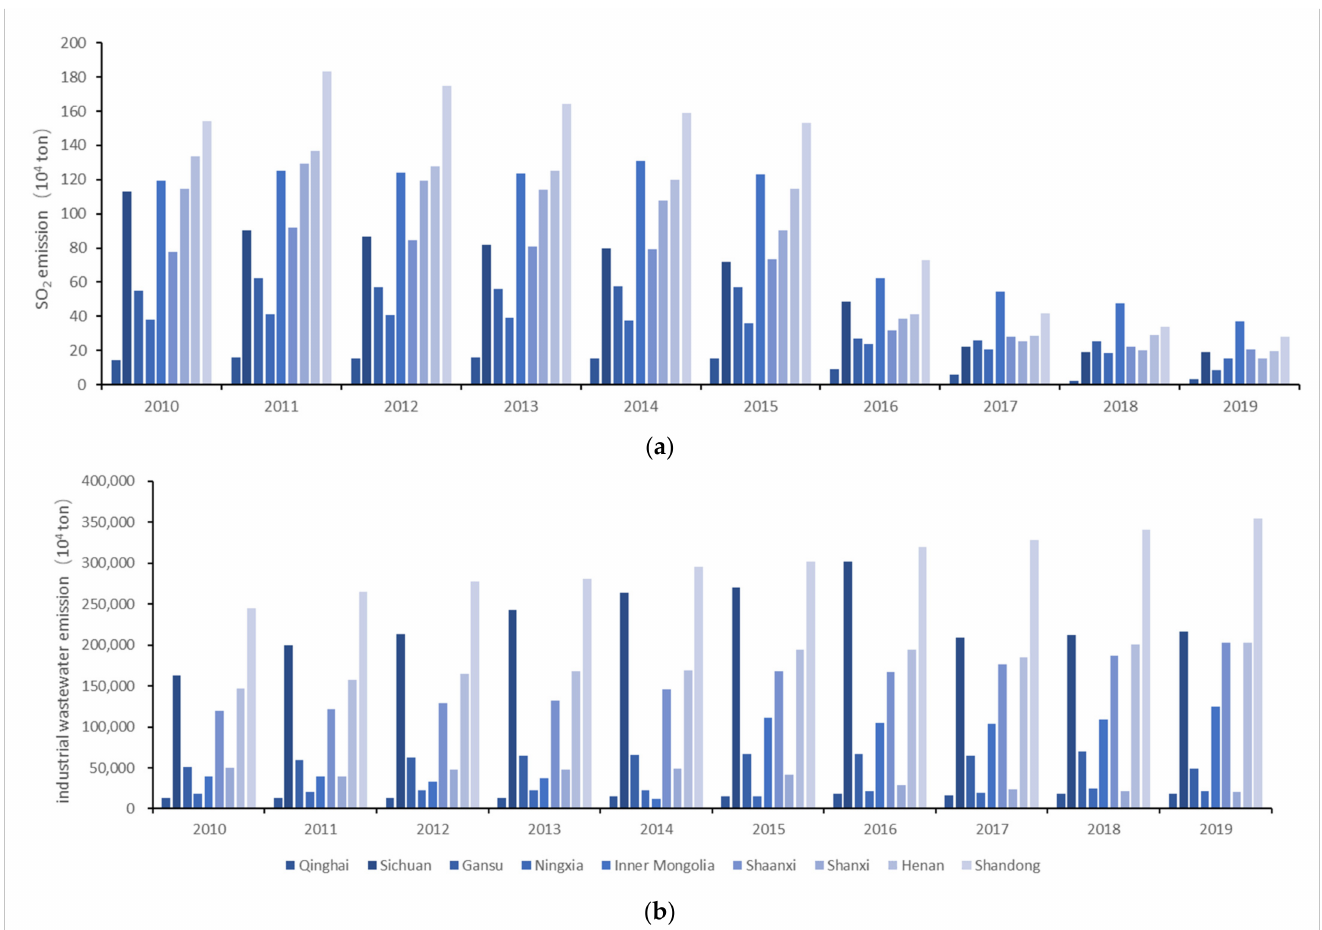
Figure 5. SO 2 and industrial wastewater emissions in the nine provinces during the study